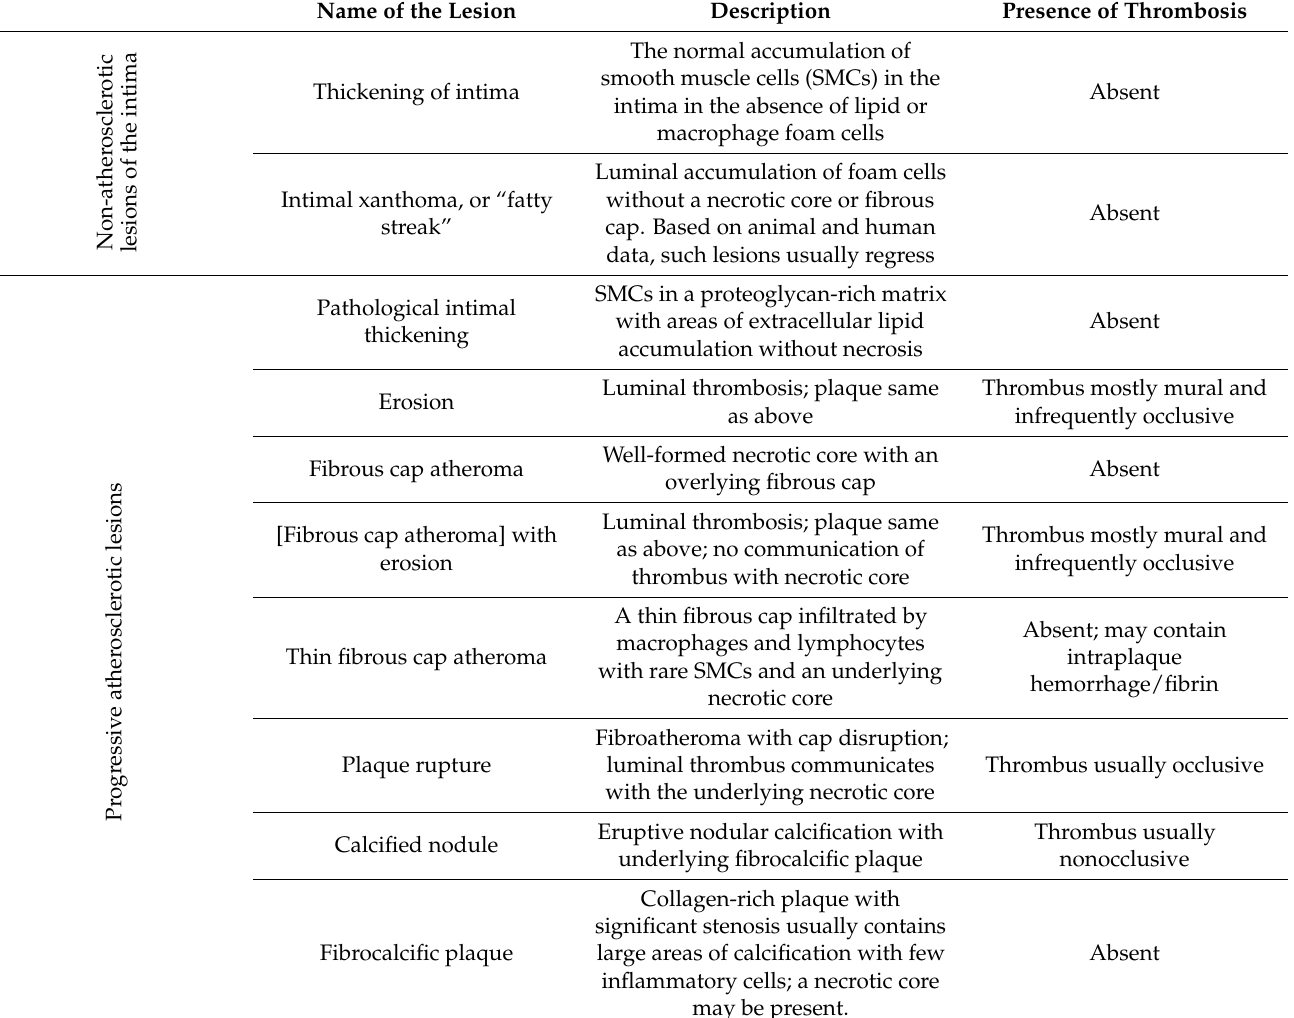
Table 1. Classification of atherosclerotic plaques according to R. Virmani et al. [14]. Name of the Lesion Description Presence of